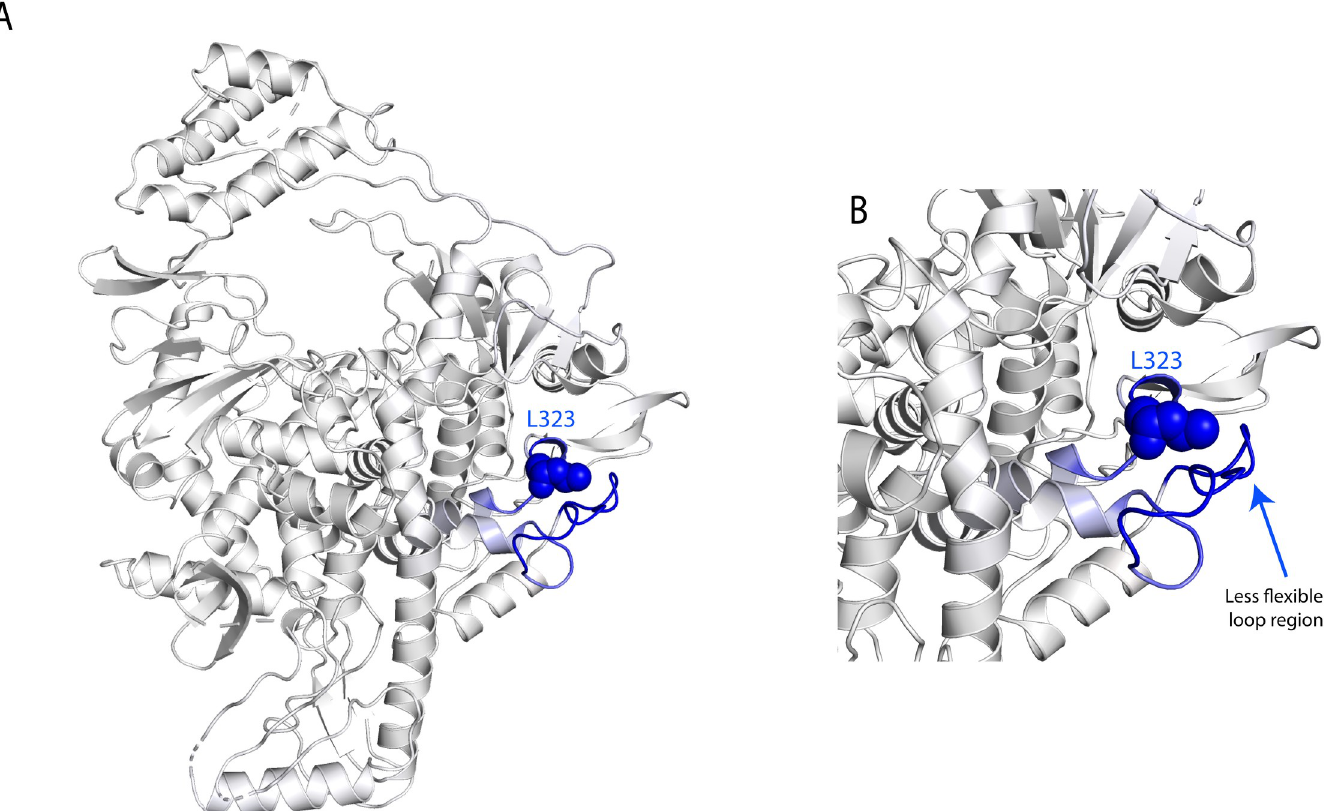
Fig 11. 3D depiction of the less relaxed loop caused by L323 mutation. (A) 3D structure of the RNA-dependent RNA polymerase where the blue region depicts a more rigid structure due to P323L mutation with an increase in stability of ΔΔ G: 0.717 kcal/mol and a decrease in vibrational entropy to ΔΔ SVib ENCoM: -0.301 kcal. mol -1 .K -1 . (B) A zoomed-in structure showing the less flexible loop region caused by the tight hydrophobic interactions between L323 and the hydrophobic moieties.